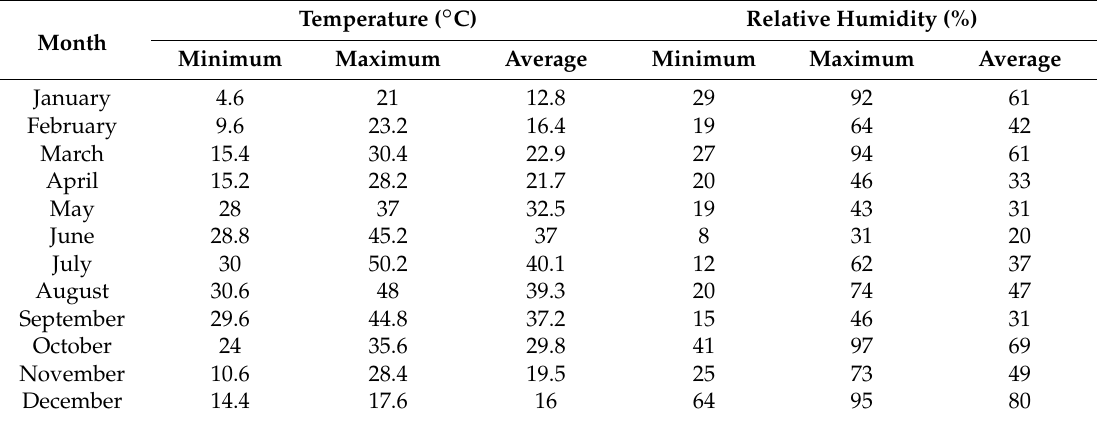
Table 1. The air temperature and relative humidity recorded in Iran, Ahvaz locality in